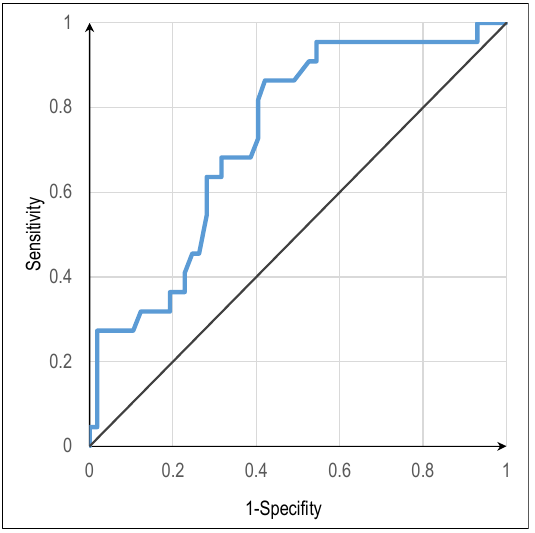
Figure 2. Receiver operating characteristic (ROC) curve showing the trade-off between sensitivity (or TPR) and specificity (1—FPR). Area under the curve (AUC) was 0.733 ( p = 0.001).